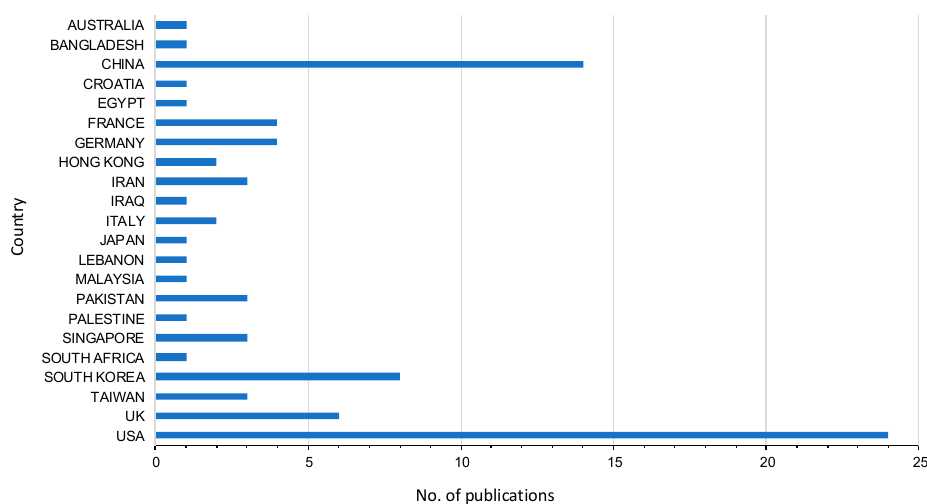
Figure 3. Number of publications per country (the country of the first author is considered).